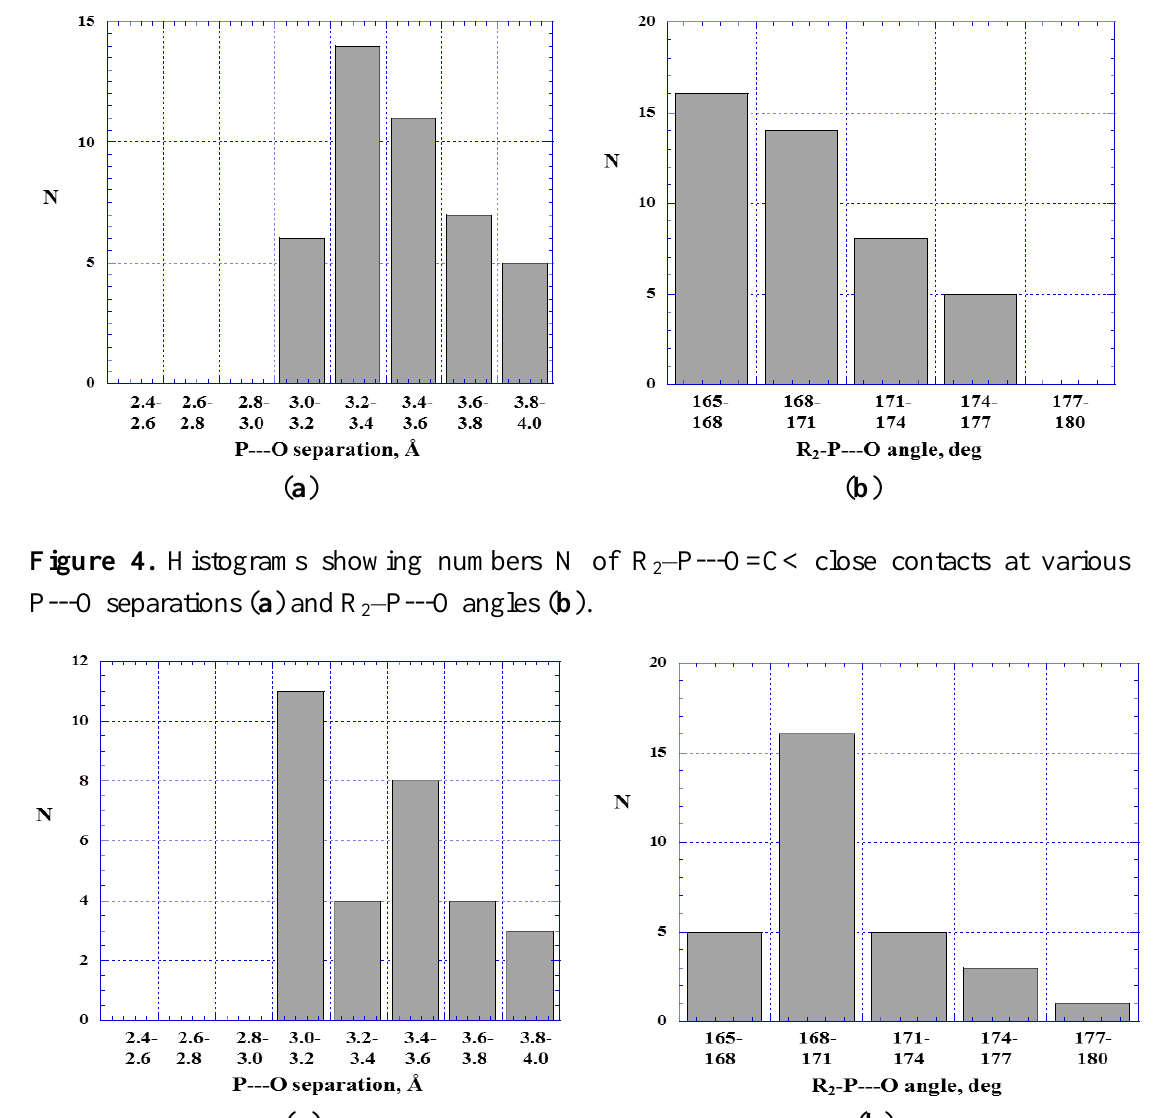
Figure 3. Histograms showing numbers N of R separations ( a ) and R –P---O angles ( b ). 2